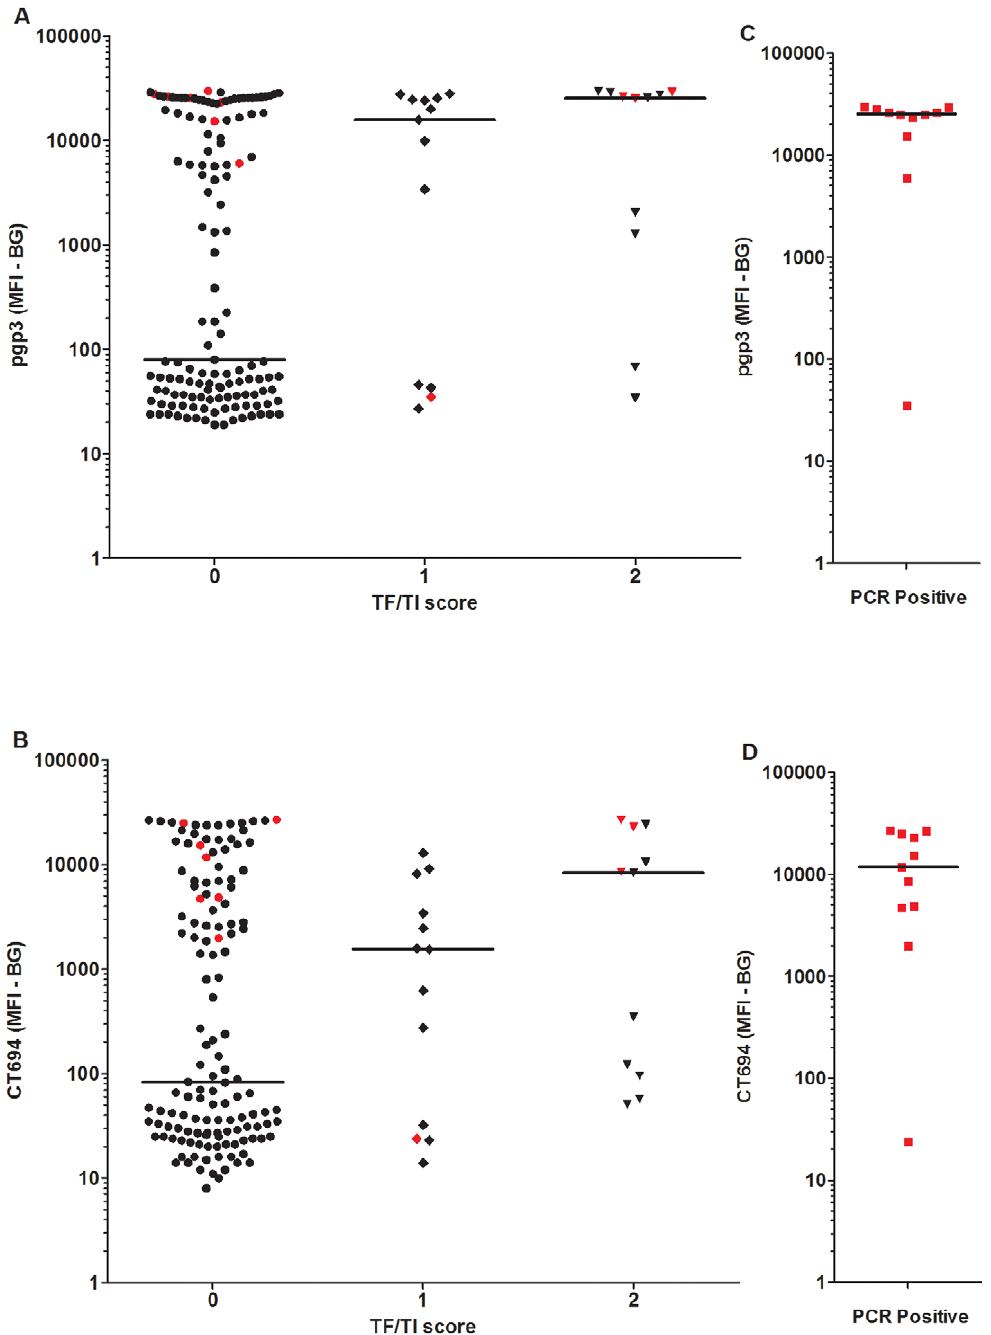
Figure 3. Antibody response by clinical diagnosis and PCR. Median responses are shown in median fluorescence intensity minus background (MFI-BG) for antibody response to (A) pgp3 and (B) CT694 in relation to clinical diagnosis. Antibody response to (C) pgp3 and (D) CT694 is shown by PCR positivity. Responses shown in red indicate PCR positivity. Antibody responses to pgp3 differed between children with no clinical signs and PCR positive children (p=0.0008) and between children with no clinical signs and those with a TF/TI score of 2 (p=0.0041). For CT694, antibody responses for children with no clinical signs were lower than for PCR positive children (p=0.0024) and for those with a TF/TI score of 2 (p=0.0282).